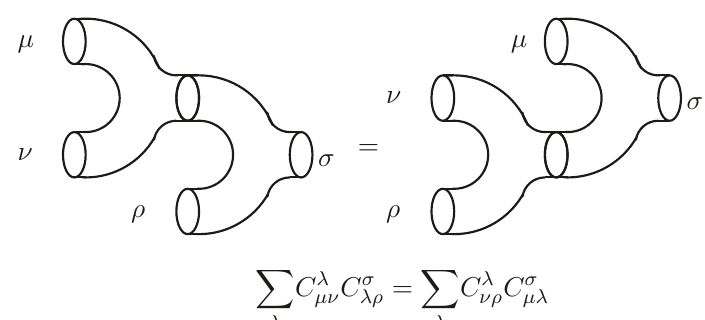
Figure 3 . Associativity of the structure constant.